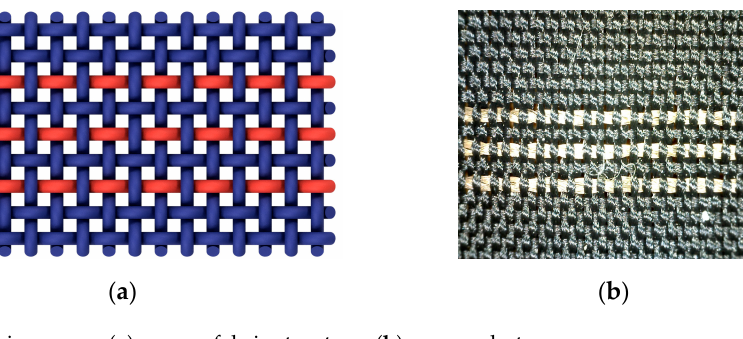
Figure 1. Plain weave: ( a ) woven fabric structure; ( b ) macro photo.